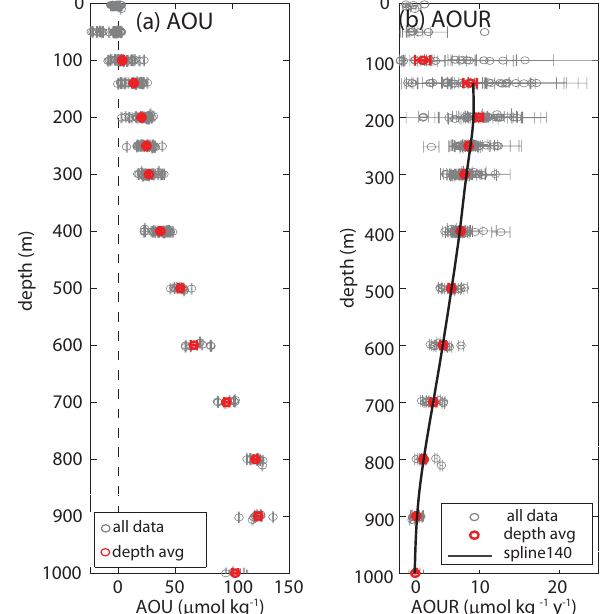
Fig. 4. (a) Apparent Oxygen Utilization (AOU) and (b) AOU Rates (AOUR) as a function of depth at BATS. Gray circles denote all the data collected whereas red circles are depth averages. A spline is fit to the AOUR data from 140m to 1000m (solid line), and the area under the spline represents the depth-integrated AOUR. Error bars on individual points represent propagated 1 σ uncertainties and errors on averages reflect 1 σ standard error of mean from multiple measurements at a given